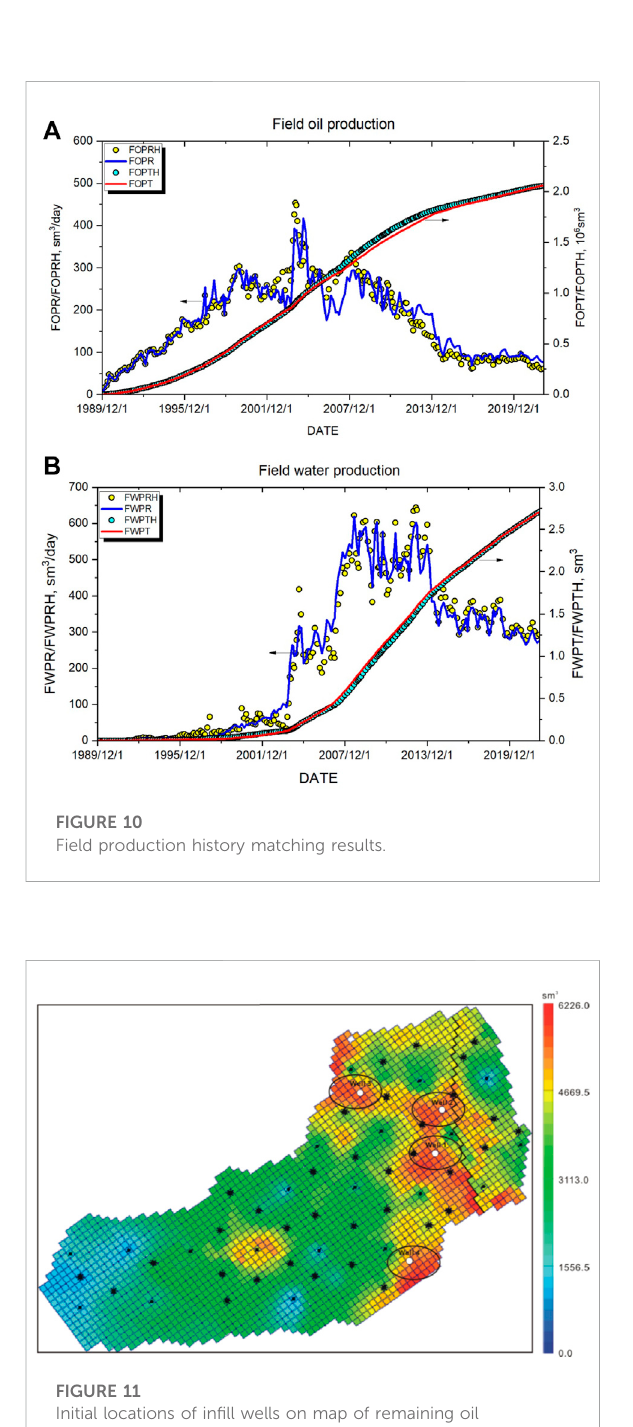
FIGURE 11 Initial locations of in fi ll wells on map of remaining oil distribution at the end of production